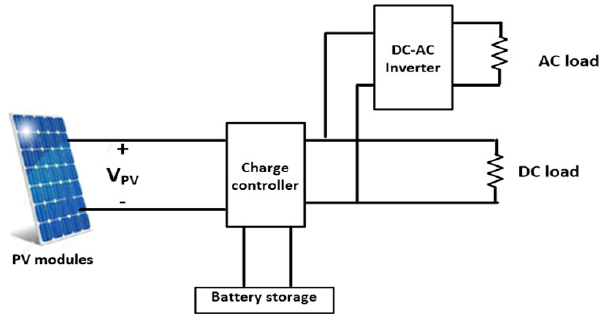
Figure 6. Typical off-grid PV system